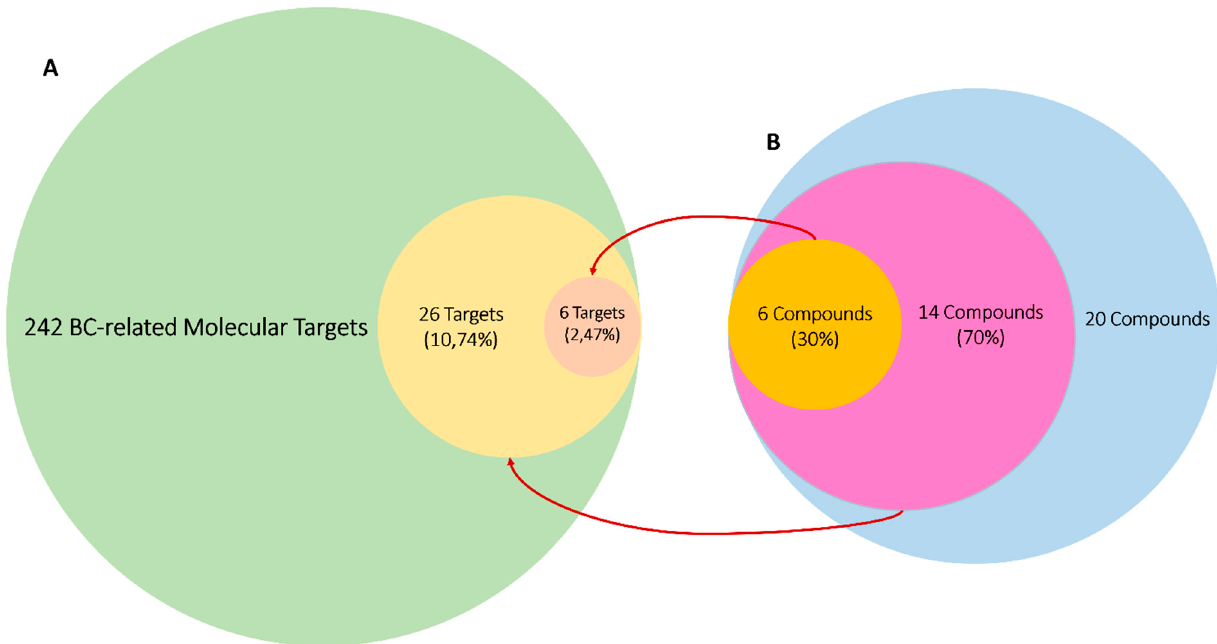
Figure 10. ( A ) The green-colored circle indicates all collected BC-related molecular targets, the yellow-colored circle indicates BC-related targets that were found to be potential targets for CE-derived compounds, and the brown-colored circle indicates protein targets that formed stable complexes with 6 CE-derived compounds over 100 ns of MDS. ( B ) The blue-colored circle indicates all major compounds that were annotated in CE ( 1 – 20 ), the pink-colored circle indicates compounds that obtained docking scores < − 7 kcal/mol with one or more BC-related proteins, and the orange-colored circle indicates compounds that achieved stable binding with their corresponding proteins. Red arrows indicate interactions between different circles.